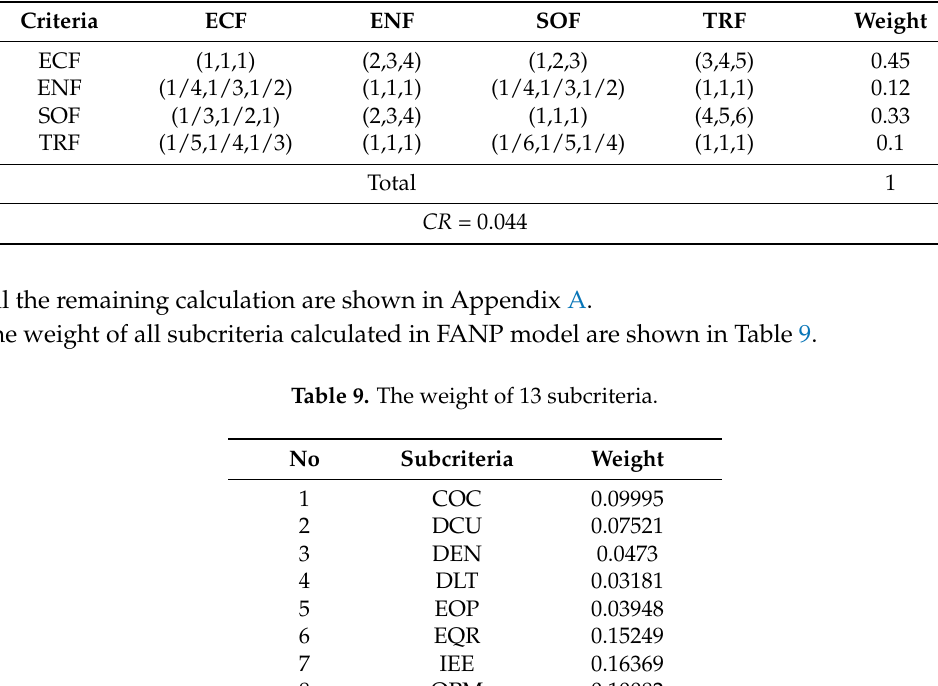
Table 8. Fuzzy comparison matrices for criteria.